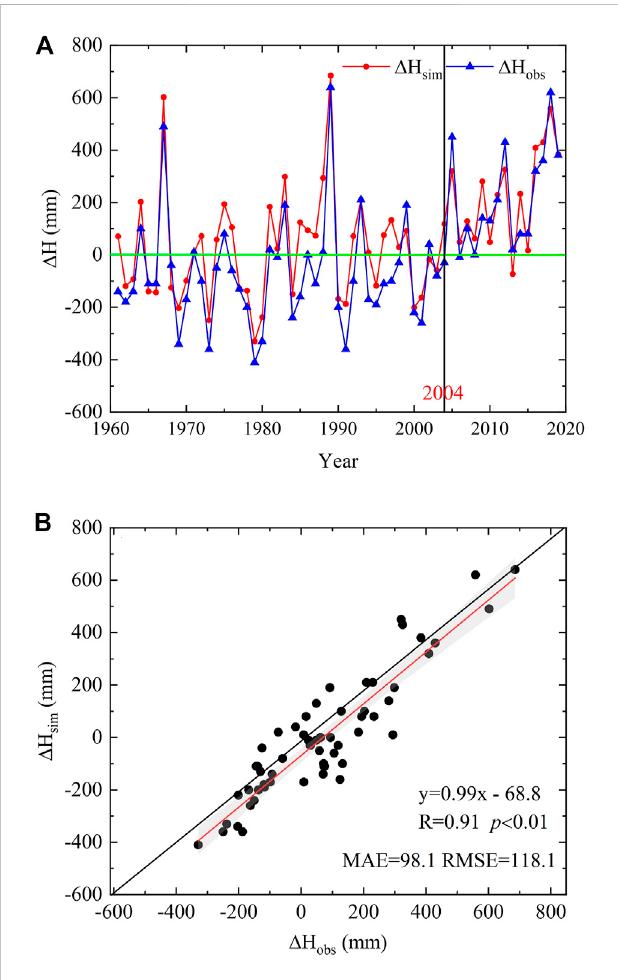
FIGURE 6 Time series of annual water balance of Qinghai Lake (A) and correlation (B) between Δ H obs and Δ H sim from 1961 through 2019. Δ H obs wascalculatedfromEq.3withhydrologicalstationobservationdata,and Δ H sim was calculated from Eq. 2 with water level balance. The red solidlineistheregression fi tbetweenthesimulatedandobservedvalues, and gray shading is the 0.95 con fi dence interval of the fi tting